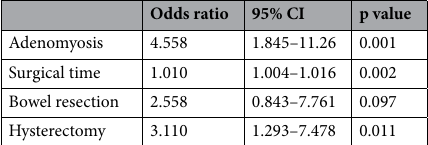
Table 4. Risk factors related to surgical complications: multivariate logistic regression analysis. CI confidential